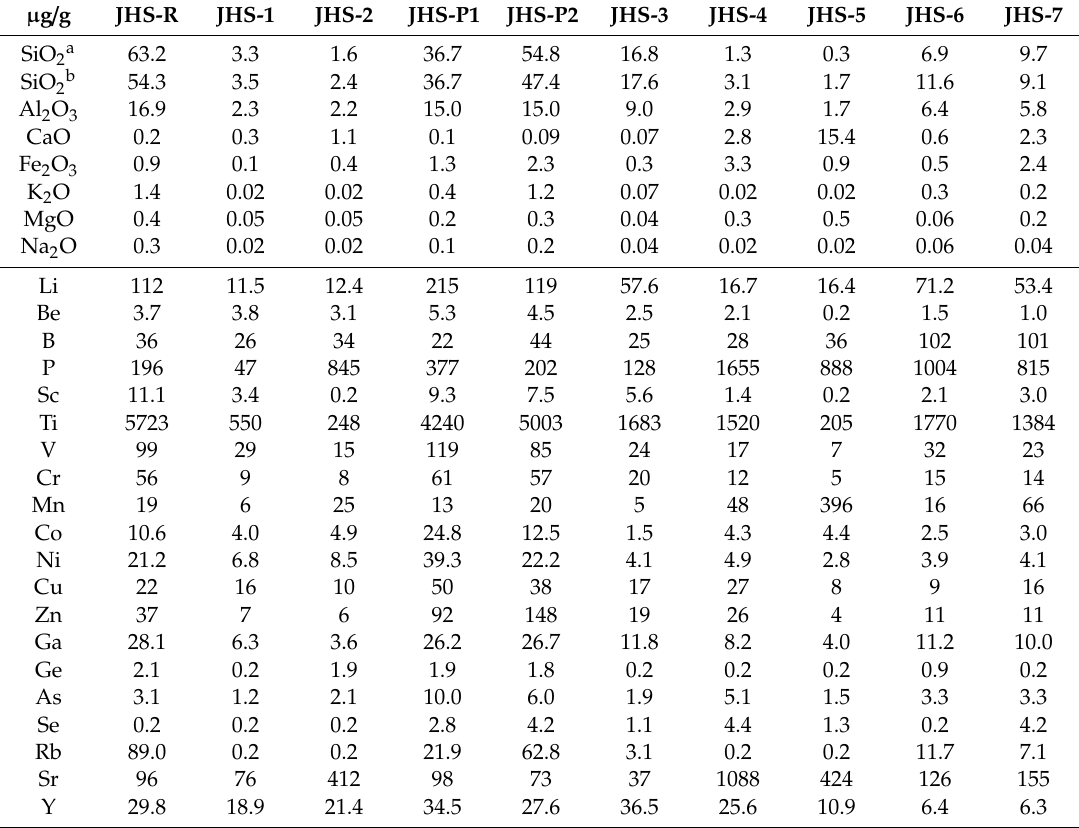
Table A4. Contents of major element oxides (%) and concentrations of trace elements ( µ g / g) of the No. 5 coal seam from Jinhuashan coal mine (on whole-coal